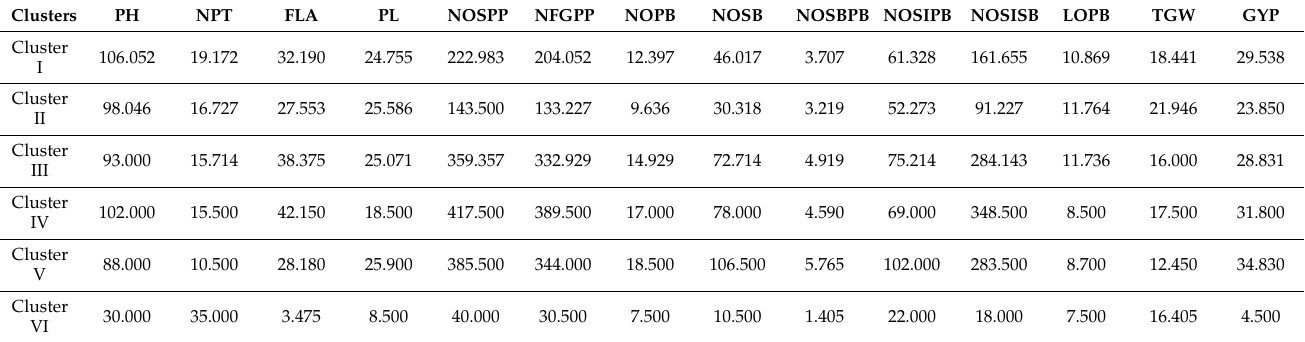
Table 3. The cluster mean value of six clusters computed from Mahalanobis’ D 2 analysis using 50 germplasm for 14 panicle- and yield-related